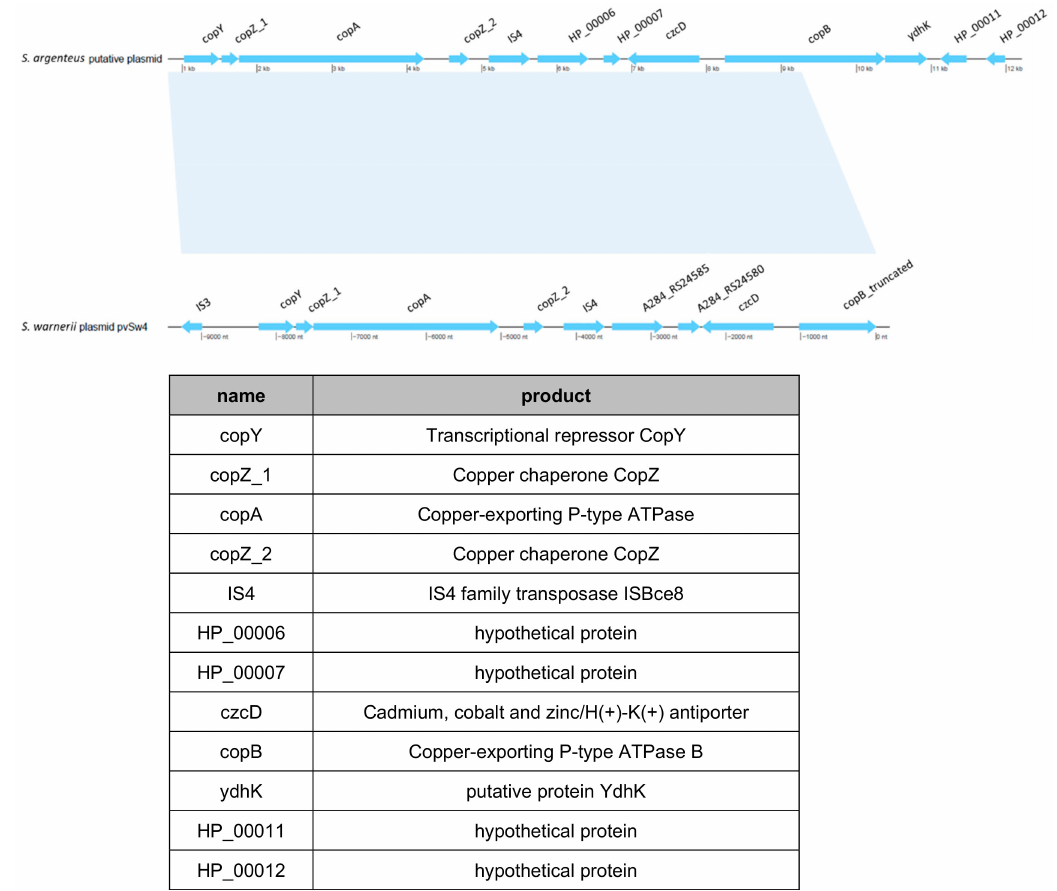
Figure 7. Identification of a putative plasmid in the S. argenteus PJI . A putative plasmid (top) was identified during the genome analysis, similar to the plasmid pvSw4 (bottom, NCBI access number: NC_020266.1) found in S. warneri [28]). The latter covers 73% and shares 99.48% of similarity with